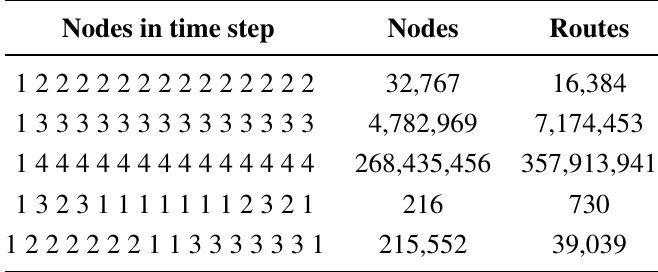
Table 1. Table showing the number of routes and the total number of nodes in the tree when using a 7.5-h horizon with a varying number of nodes in each time